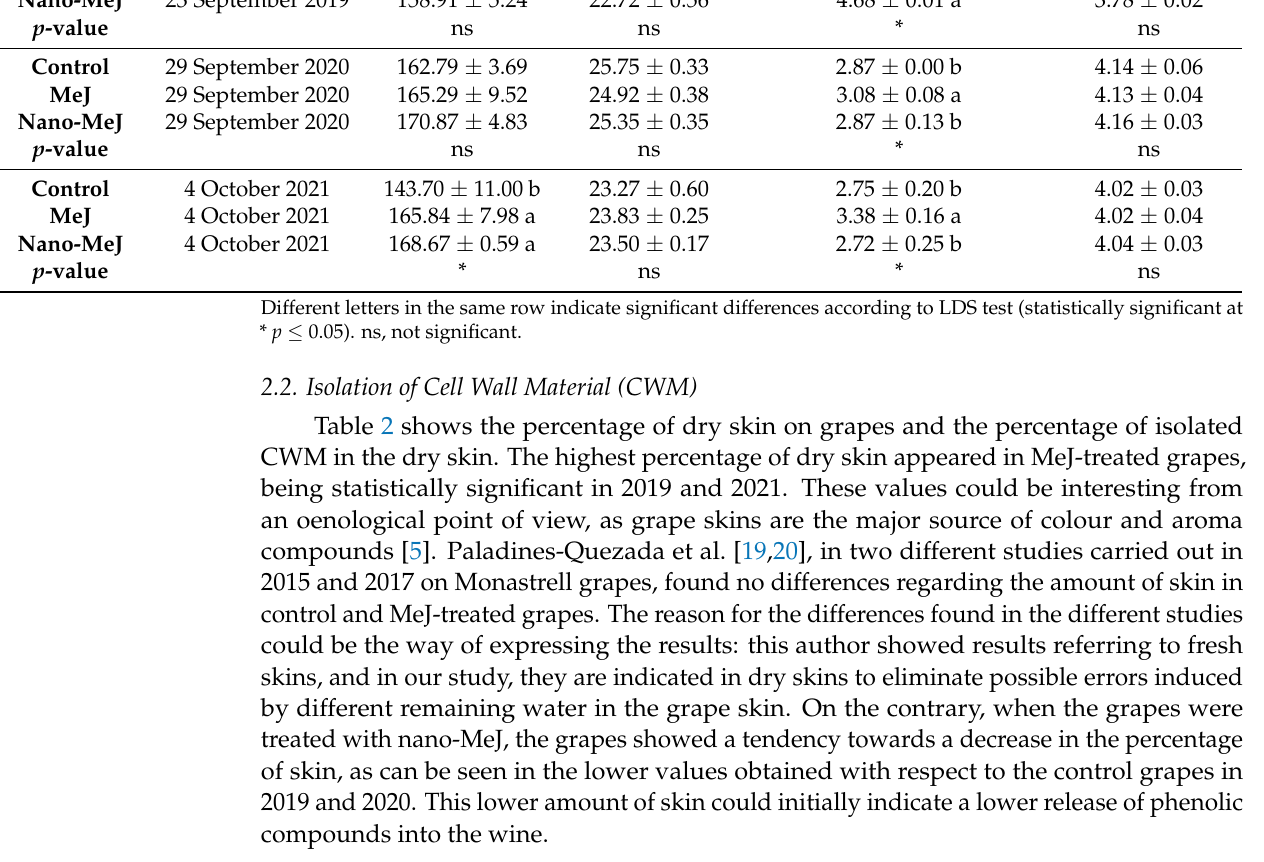
Table 2. Percentage of dry skin in grapes and percentage of cell wall in the dry skin of different treatments during three